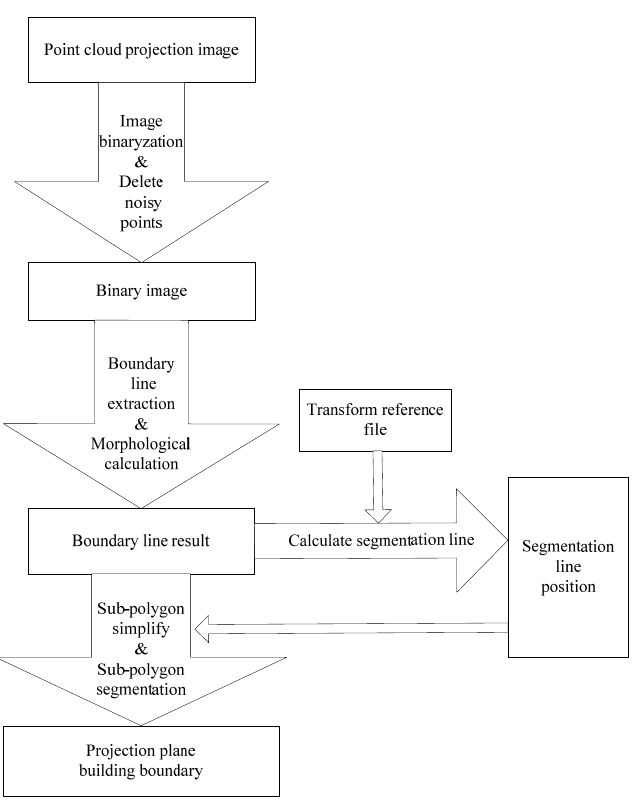
Figure 5. Façade feature extraction algorithm with point cloud projection image.